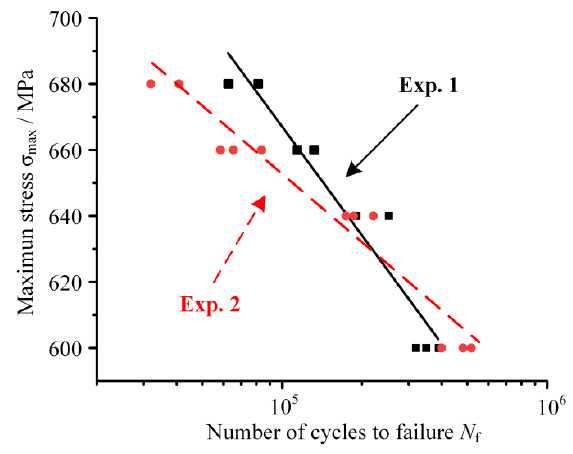
Figure 4. Fatigue life of 20Cr specimens under different load conditions.